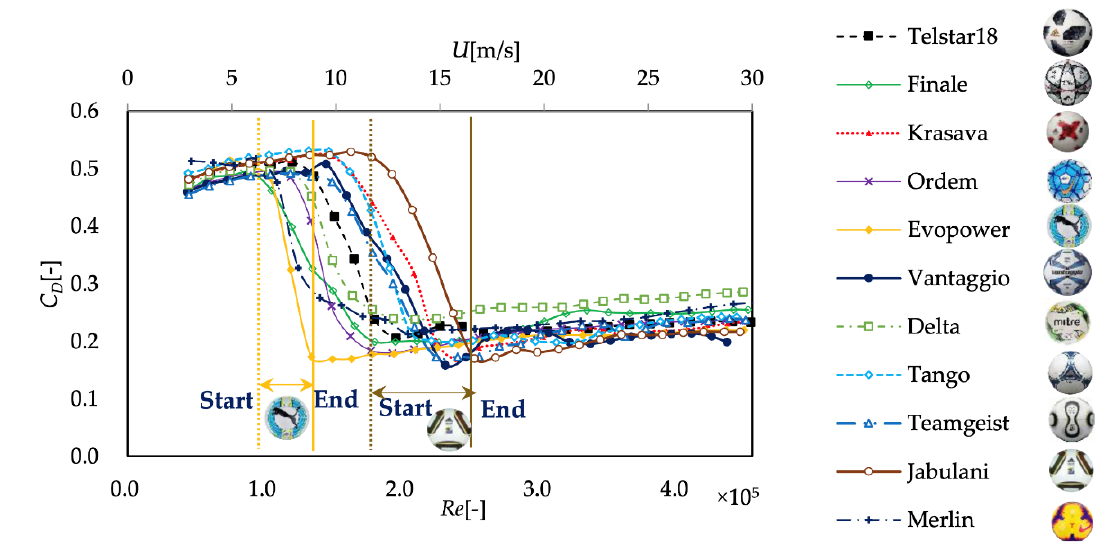
Figure 8. The drag coefficient ( C D ) diagram of each ball.